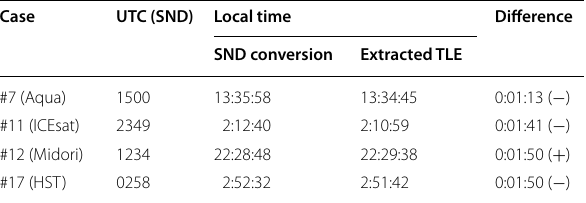
Table 3 Comparison of mean SLT derived from SND and the extracted TLE for selected cases